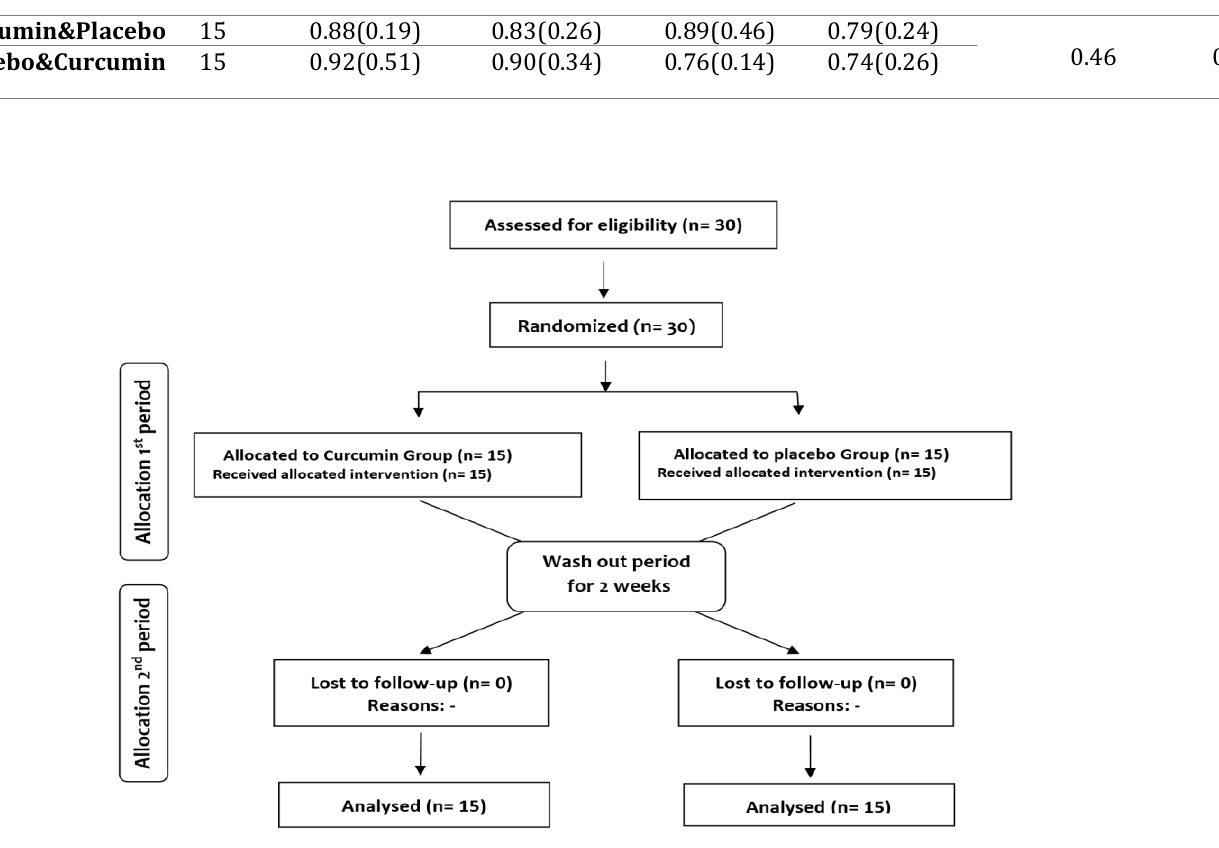
Figure 1: Flow chart of